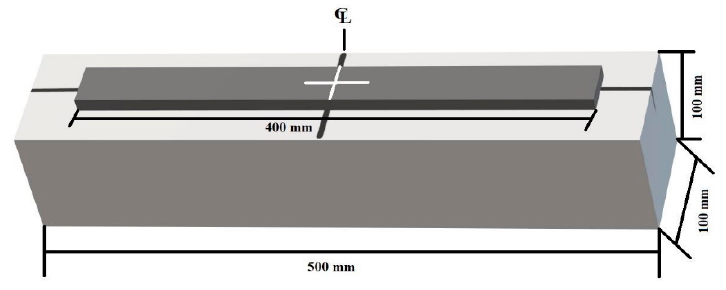
Figure 1. Beam dimensions.